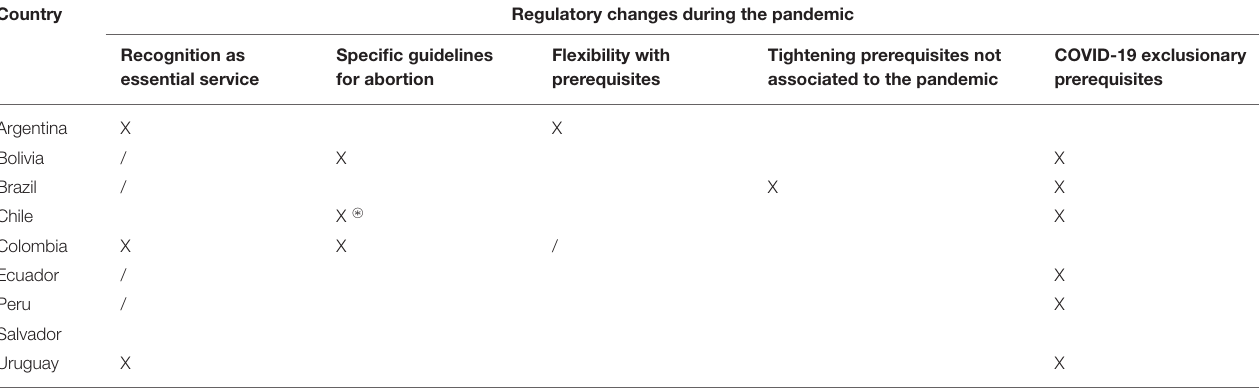
TABLE 6 | Regulatory changes on abortion during the pandemic * . Country Regulatory changes during the pandemic Recognition as essential